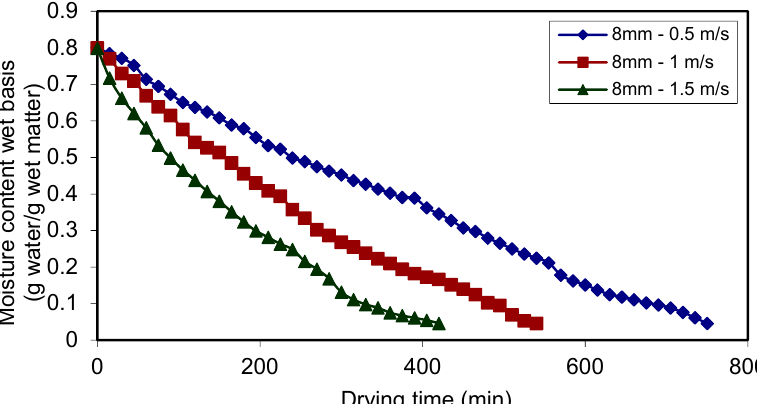
Figure 3. Moisture content wet basis as a function of drying time for drying air velocity of 0.5, 1 and 1.5 m/s and slice thicknesses of 4 mm for kiwi fruits.